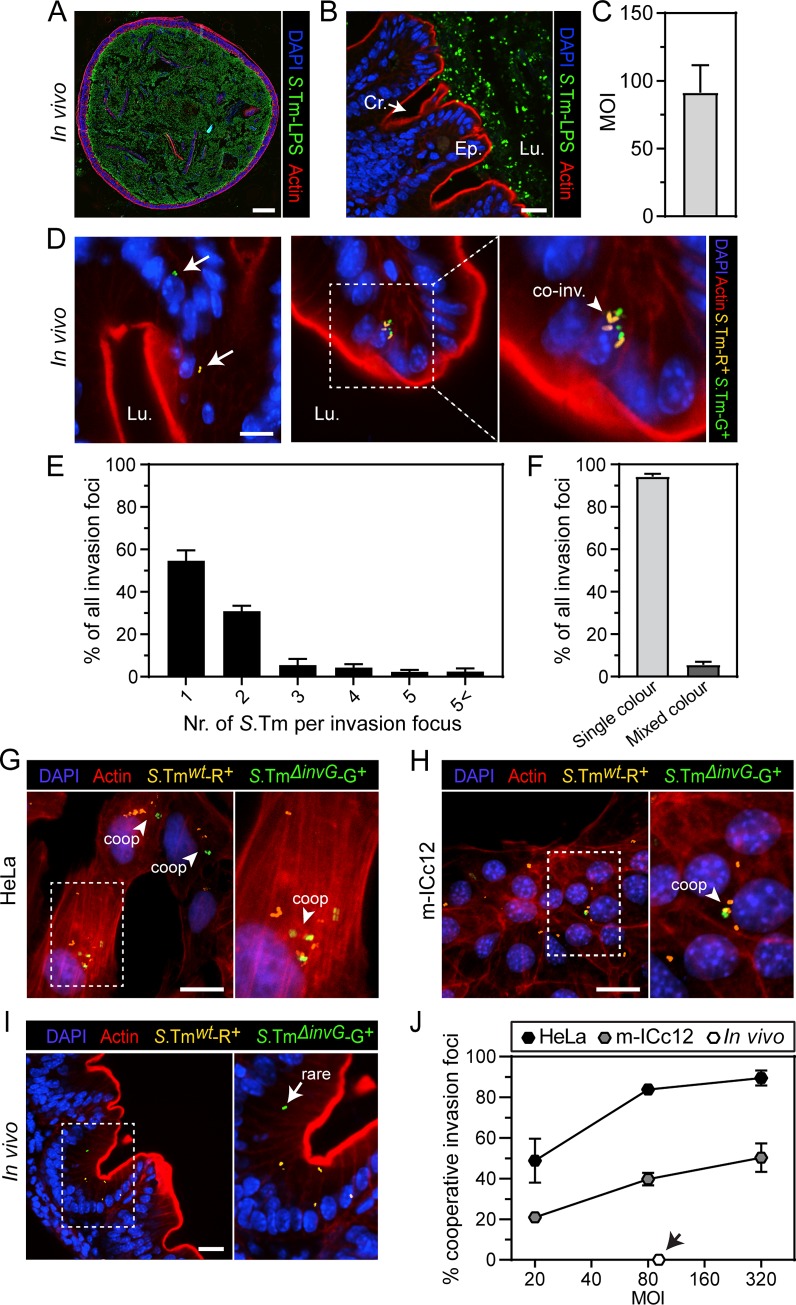
Cooperative S.Tm invasion occurs frequently in epithelial cell lines, but not in the absorptive gut epithelium of mice.(A-C) S.Tm Multiplicity of Infection (MOI) in the gut of (Sm-pretreated) orally infected mice. Inflammasome-deficient (Nlrc4-/-) mice were orally infected with S.Tmwt for 12h. (A) Representative stitched image of an entire cross-section of the infected murine cecum. Scale bar: 500μm. (B) Representative up-close micrograph of the infected cecum lumen and mucosa. Lu.—Lumen; Ep.—Epithelium; Cr.—Crypt. Scale bar: 20μm. (C) Microscopy-based quantification of the MOI in the infected mouse cecum. Bar correspond to mean +/- SD of replicate infections in four mice. (D-F) S.Tm co-invasion occurs rarely in the mouse gut. Inflammasome-deficient (Nlrc4-/-) mice were orally infected with a 1:1 mix of S.Tmwt/pssaG-mCherry and S.Tmwt/pssaG-GFP strains for 12h. (D) Representative micrographs of the cecal epithelium. Blow-up shows magnification of boxed region. Lu.—Lumen. White arrows indicate one-coloured invasion foci; arrow head labelled “co-inv” indicates a mixed invasion focus. Scale bar: 10μm. (E) Quantification of the distribution of bacterial numbers within S.Tm invasion foci. (F) Quantification of the frequency of single-colour and mixed colour invasion foci in vivo. Bars in E-F correspond to mean +/- SD of replicate infections in four mice (Ntot = 1055 invasion events analyzed). (G-J) Prevalent cooperative S.Tm invasion in epithelial cell lines, but not in the absorptive gut epithelium in vivo. (G-H) Infection of (G) HeLa and (H) m-ICc12 cells with a 1:1 mix of S.Tmwt/pssaG-mCherry and S.TmΔinvG/pssaG-GFP strains for 1h at MOI 80. Representative micrographs. Blow-ups show magnifications of boxed regions. Arrow heads labelled “coop” indicate cooperative invasion foci. Scale bar: 20μm. (I) Inflammasome-deficient (Nlrc4-/-) mice were orally infected with a 1:1 mix of S.Tmwt/pssaG-mCherry and S.TmΔinvG/pssaG-GFP strains for 12h. Representative micrographs of the cecal epithelium. Blow-up shows magnification of boxed region. Arrow points to a rare S.TmΔinvG/pssaG-GFP invasion focus. Scale bar: 20μm. (J) Quantification of the frequency of cooperative invasion foci in HeLa, m-ICc12 cells (infection parameters as in G-H) and the absorptive gut epithelium in vivo (infection parameters as in I). Data points correspond to mean +/- SD of three replicate infections in HeLa and m-ICc12 cells, and to mean +/- SD of five mice (Ntot = 578 in vivo invasion events analyzed), respectively.